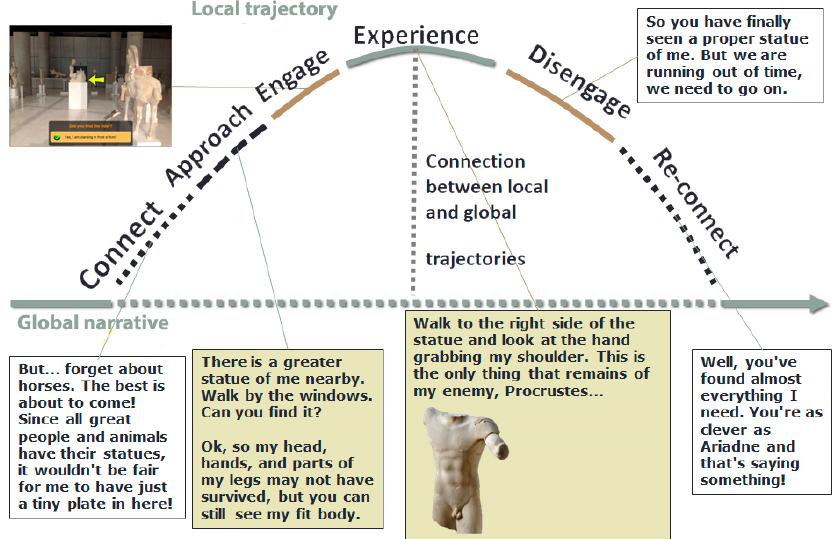
Figure A3. An example of an annotated local trajectory applied to a script unit of the Theseus story.